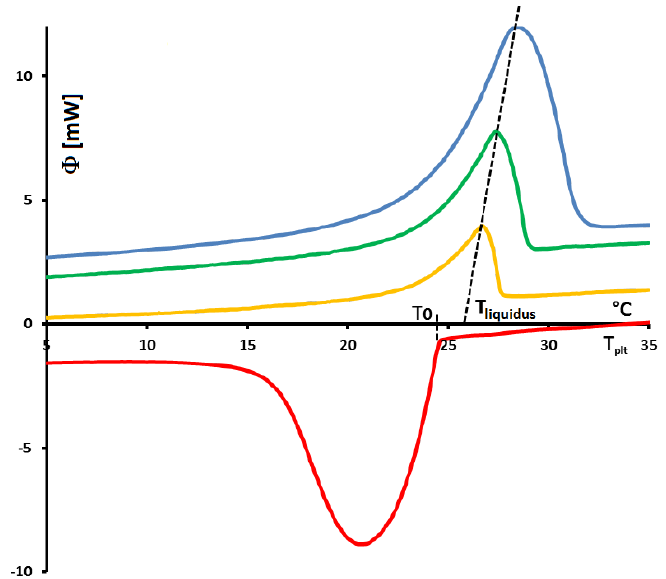
5 K/min (red curve) and at the heatings at −